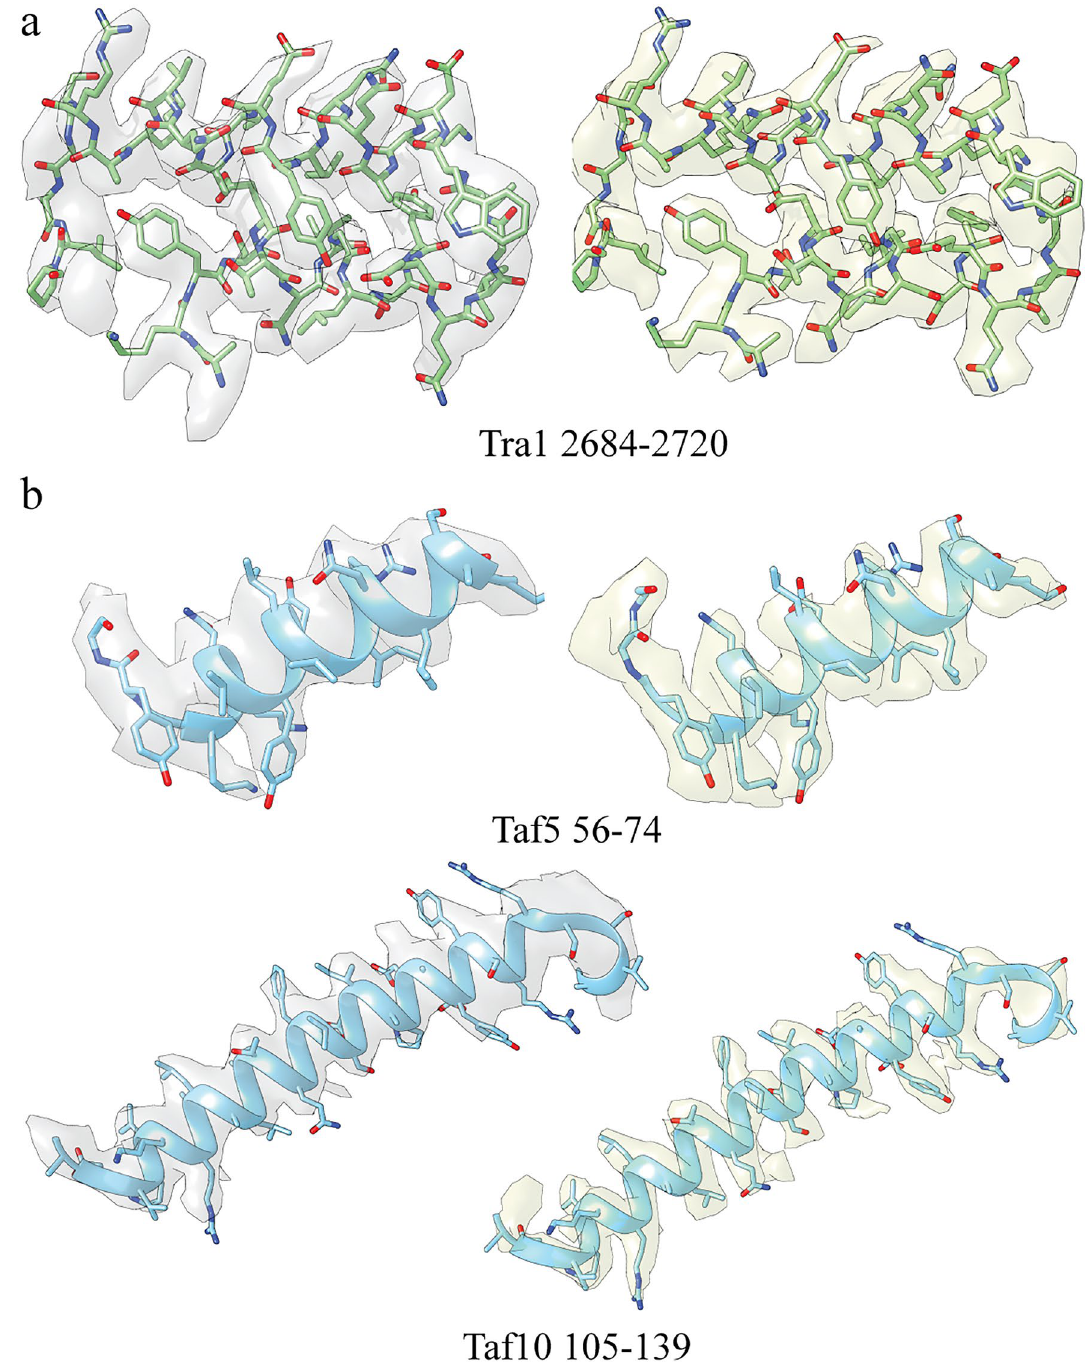
Figure 3. Cryo-EM density analysis of SAGA. ( a ) Cryo-EM density in select regions of Tra1 of the obtained map (left) and the map from Wang et al. (right) 24 . ( b ) Cryo-EM density in select regions of the core module of the obtained map (left) and the map from Wang et al. (right) 24 . All illustrations were prepared using UCSF Chimera 31